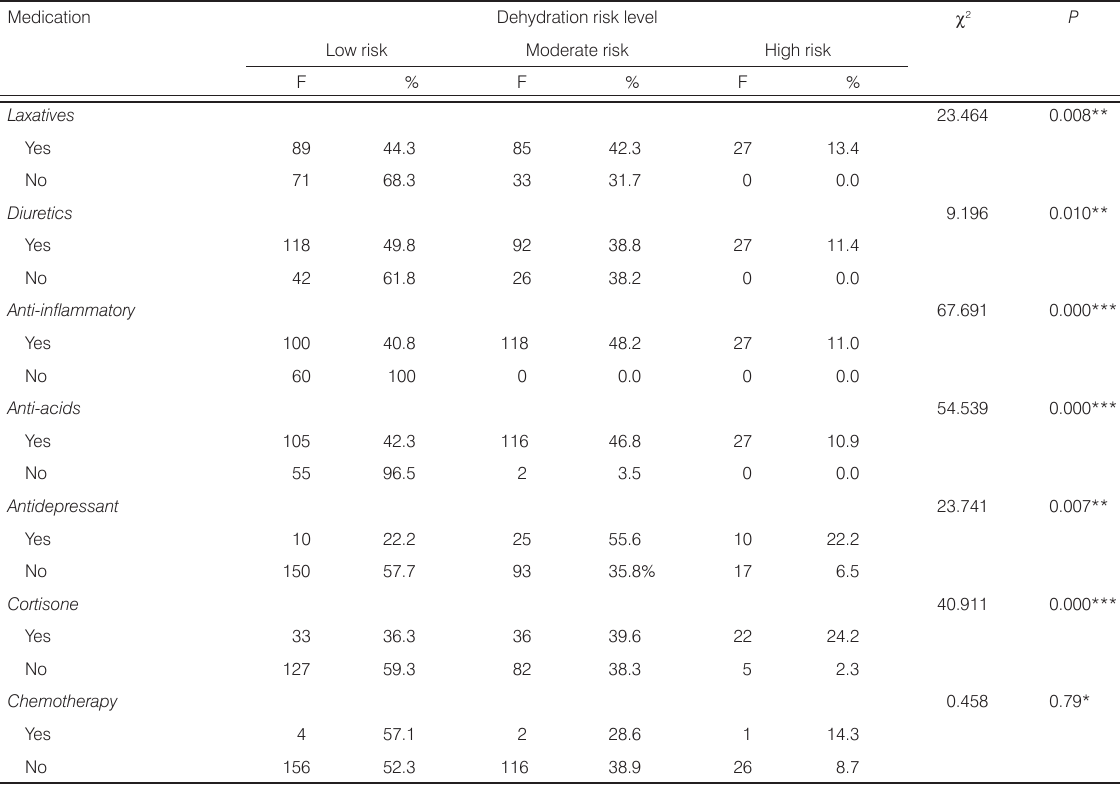
Table 6. Correlation between the type of medication and risk for dehydration (N =